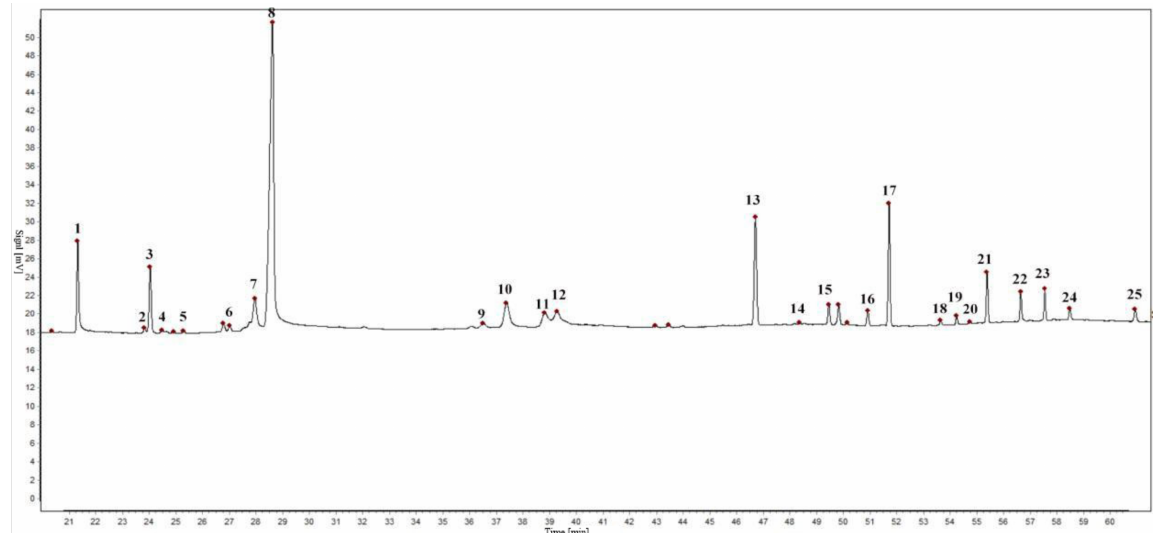
Figure 1. Gas chromatogram of S. chamaejasme